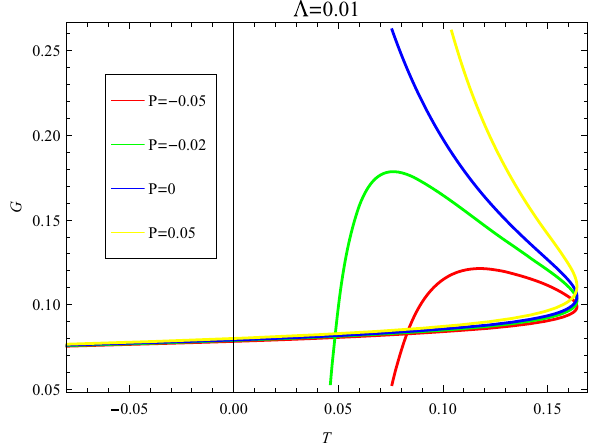
Fig. 9 Plot of G versus T of the RBH with cosmological constant in NED